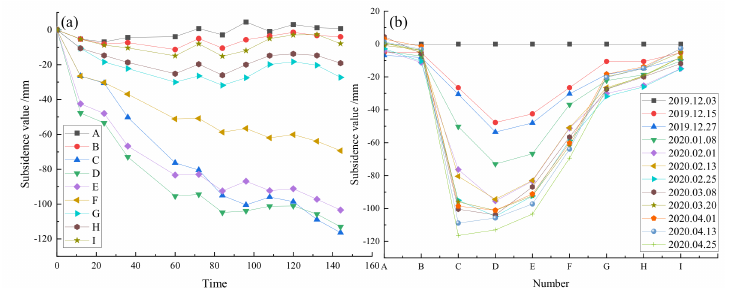
Figure 9. Subsidence of the strike points: ( a ) Subsidence of the points with time. ( b ) Cumulative subsidence at each time.